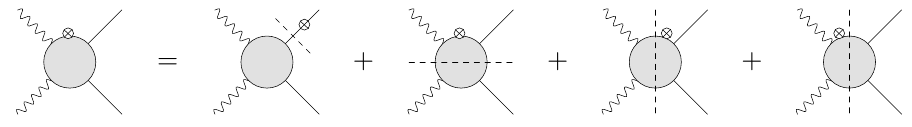
Figure 3 . Unitarity cuts for γ ∗ γ ∗ γ → 2 π for a soft external on-shell photon. The first cut on the r.h.s. denotes the soft divergence, the second diagram denotes the left-hand cut. The last two diagrams are the two s -channel cuts. Crossed diagrams are not shown.